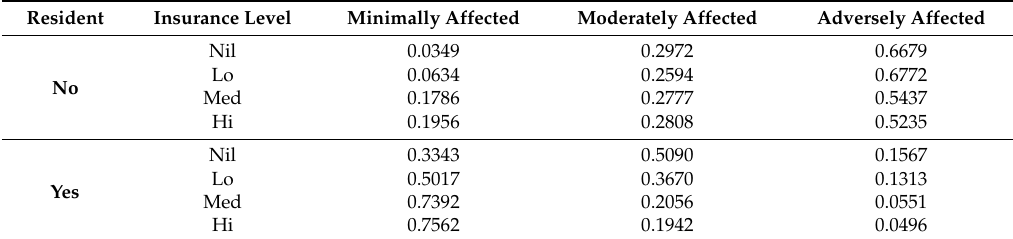
Table 5. Probabilities of financial distress upon residency and insurance of